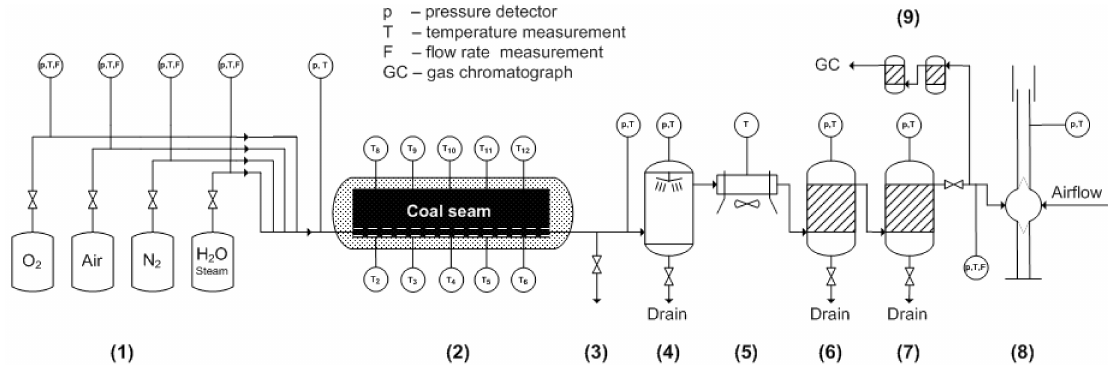
Figure 1. Schematic view of the ex-situ high pressure UCG installation. Reproduced from K. Kapusta et al. [1]. ( 1 ) reagent supply system, ( 2 ) gasification reactor, ( 3 ) tar sampling point, ( 4 ) water scrubber—wastewater sampling point, ( 5 ) air cooler for process gas, ( 6 , 7 ) gas separators, ( 8 ) thermal combustor, ( 9 ) gas purification module for GC analysis.